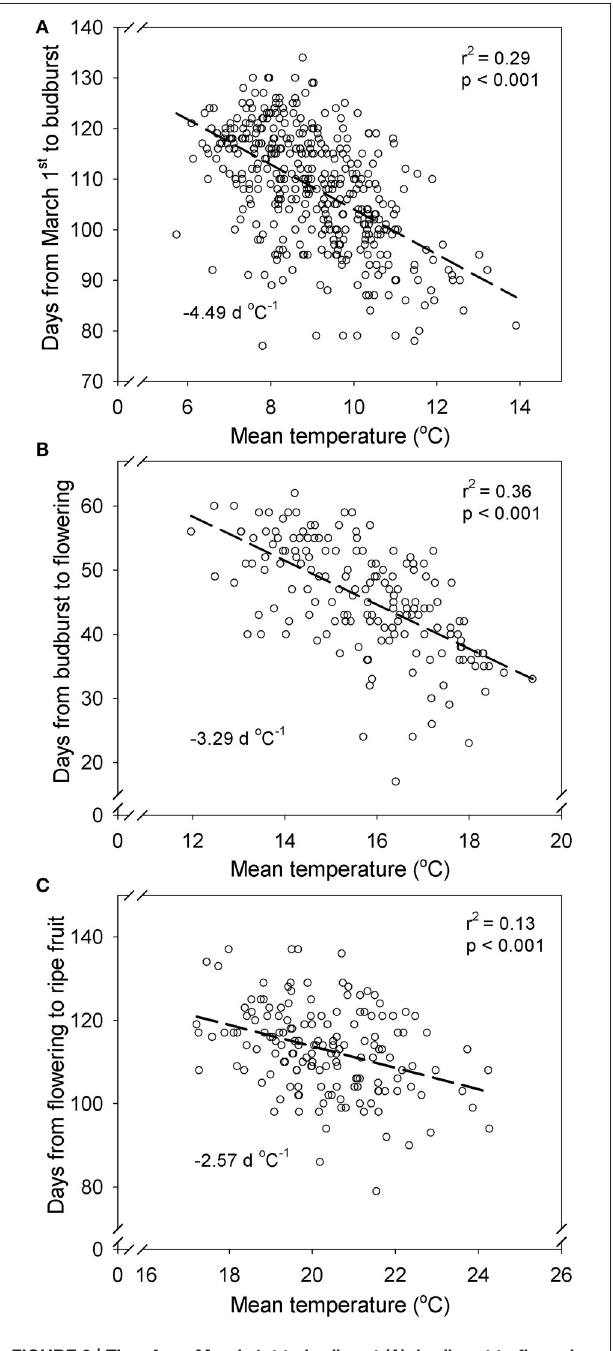
FIGURE 3 | Time from March 1st to budburst (A), budburst to flowering (B) and flowering to ripe fruit stage (C) vs. mean temperature for that period for each year and place. Data from 9 plantings in Daruvar, Cepic, KriZevCi, Mandicevac and Trsteno (Croatia) (historical data from 1961 to